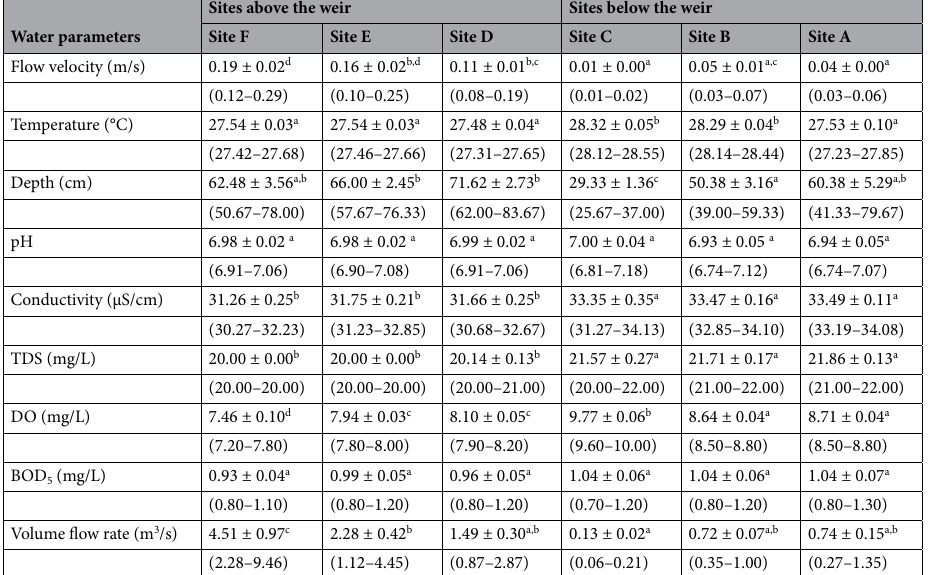
Table 2. Physico-chemical parameters of water measured at the six sampling sites of the Gurugoda Oya (n=7 for each site). Sites F–D–E are located above the weir, and sites C–B–A below the weir (see Fig. 5). Values are mean ± SD, and range (min-max) within brackets. TDS, Total Dissolved Solids; DO, Dissolved Oxygen; BOD 5 , five-day Biological Oxygen Demand. Different superscript letters in a row show significant differences ( p < 0.05) indicated by Tukey test after one-way ANOVA.